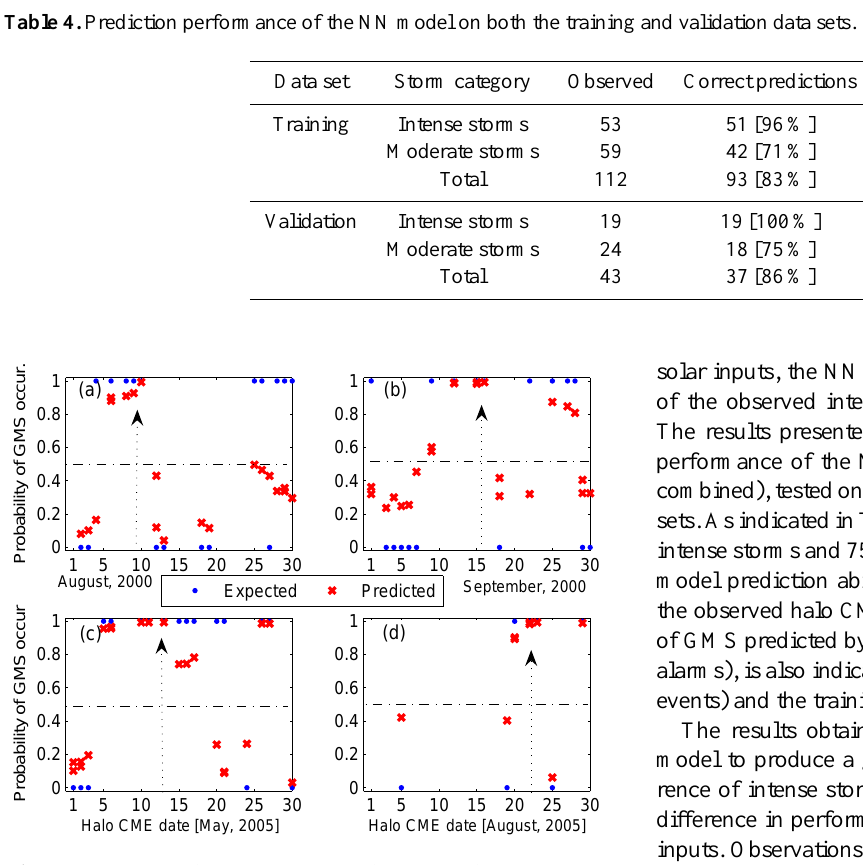
Fig. 3. Illustration of the prediction performance of the model on some storms in the validation data set. All predictions above a 0.5 probability value indicate a successful prediction (of storm occur- rence), where the predicted value can be interpreted as the proba- bility by which a particular halo CME may be followed by a storm. Example events described in the text are indicated by the arrows.